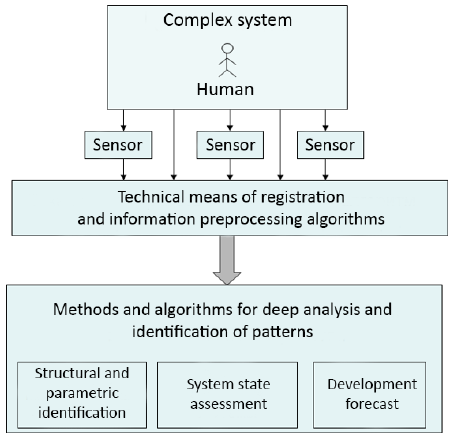
Fig. 1. Functional diagram of the complex.